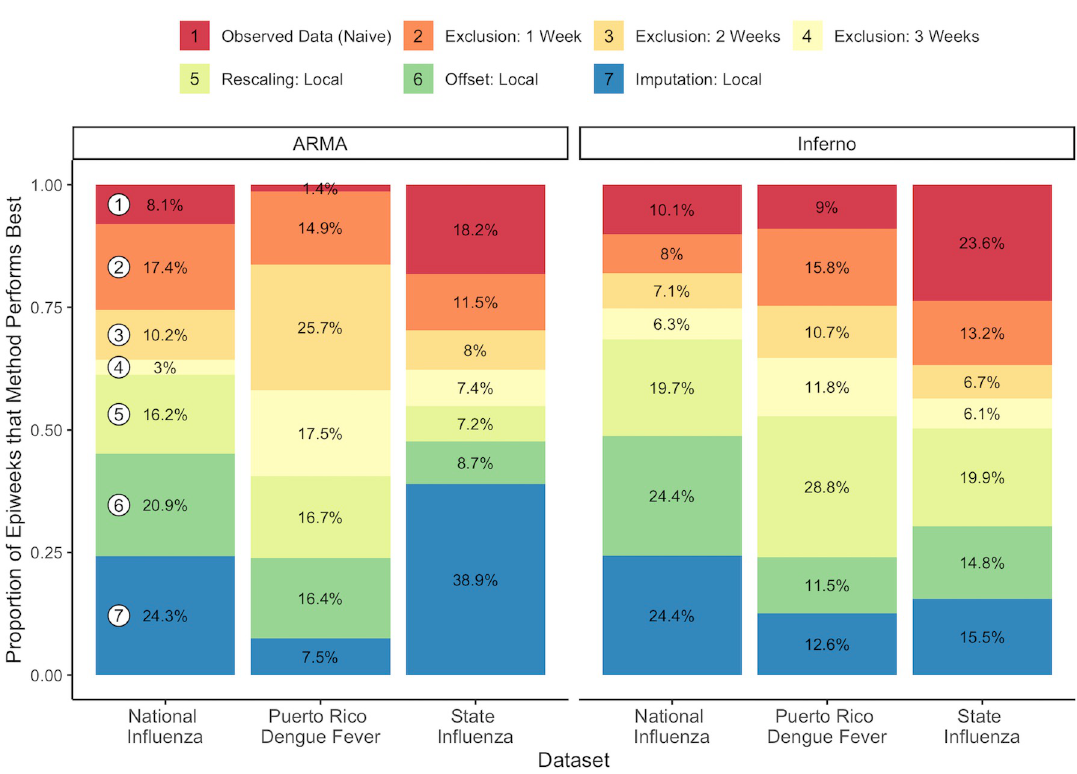
Fig 4. Proportion of weeks in which each of 4 methods performs best in terms of 1-week forecast weighted interval scores. 1 Results for Dengue fever in Puerto Rico are aggregated across all 50 weeks in 18 calendar years (1992–2009). Results for US national influenza are aggregated across 35 weeks in 7 seasons (2012–2013 through 2018–2019). Results for US state-level influenza are aggregated across 35 weeks in 49 states (excluding Florida) for the 2018–2019